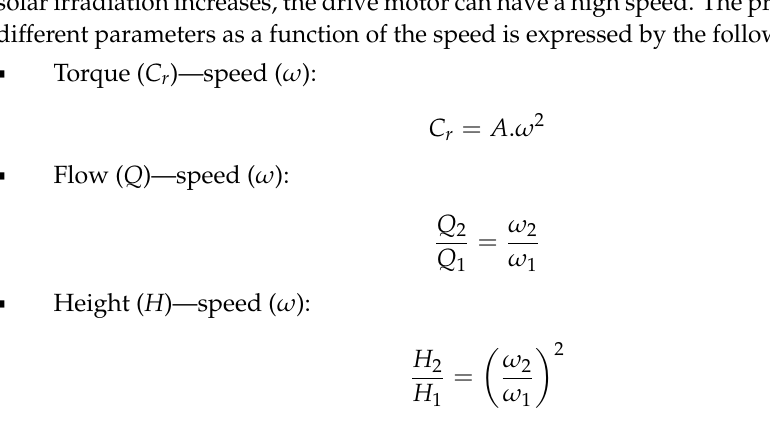
Figure 4. Electrical diagram of a SEPIC converter [28].